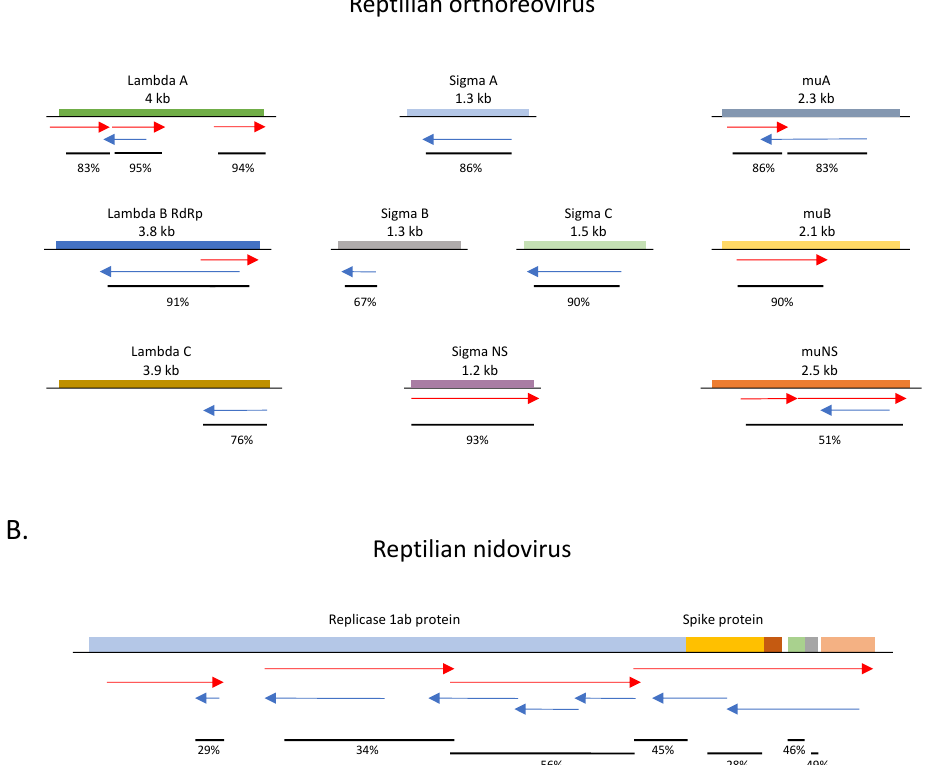
Figure 6. Chameleon dsRNA contigs with protein similarity to known viruses. Diagrams of viruses with coding regions indicated by colored boxes. The locations where contigs shared protein similarities to the virus are indicated by arrows. Contigs representing the positive strand of the virus are displayed by red arrows; the negative strand by blue arrows. The percentage identity between the region in the contig and the corresponding protein coding sequence in the reference virus is indicated below the contigs. ( A ) Schematic of chameleon dsRNA contigs aligned to portions of all ten protein coding segments of reptilian orthoreovirus. The lengths of viral genome segments are indicated. ( B ) Schematic of a reptilian nidovirus displaying the alignment of chameleon dsRNA contigs that had similarity to protein coding sequences of snake and lizard